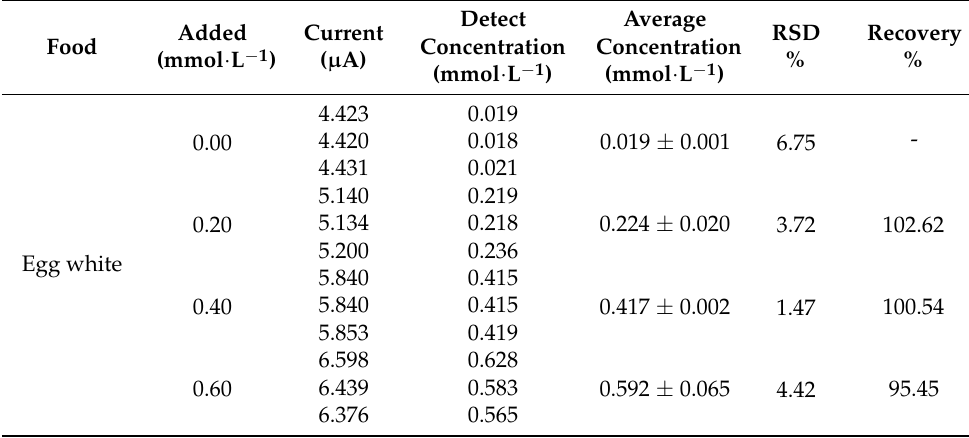
Table 1. Results of Lyz detection in egg white samples (n =